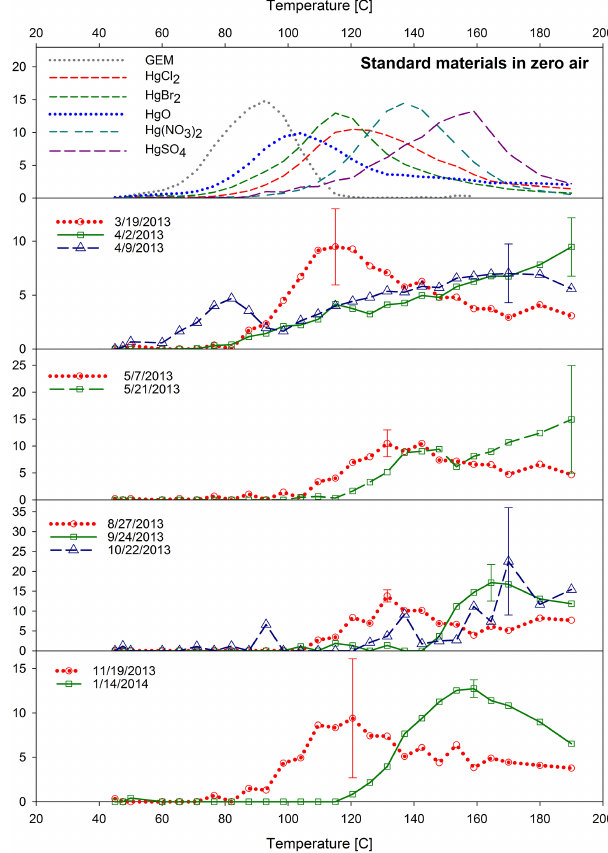
Figure 2. Desorption profiles from nylon membranes with standard materials in laboratory investigation (top) and field measurements. Each whisker is 1 standard variation, and only present in the desorp- tion peak. Note the Hg–nitrogen compound in the permeation tube (cid:113) was HgN 2 O 6 H 2 O. The y axis indicates the percentage released at each